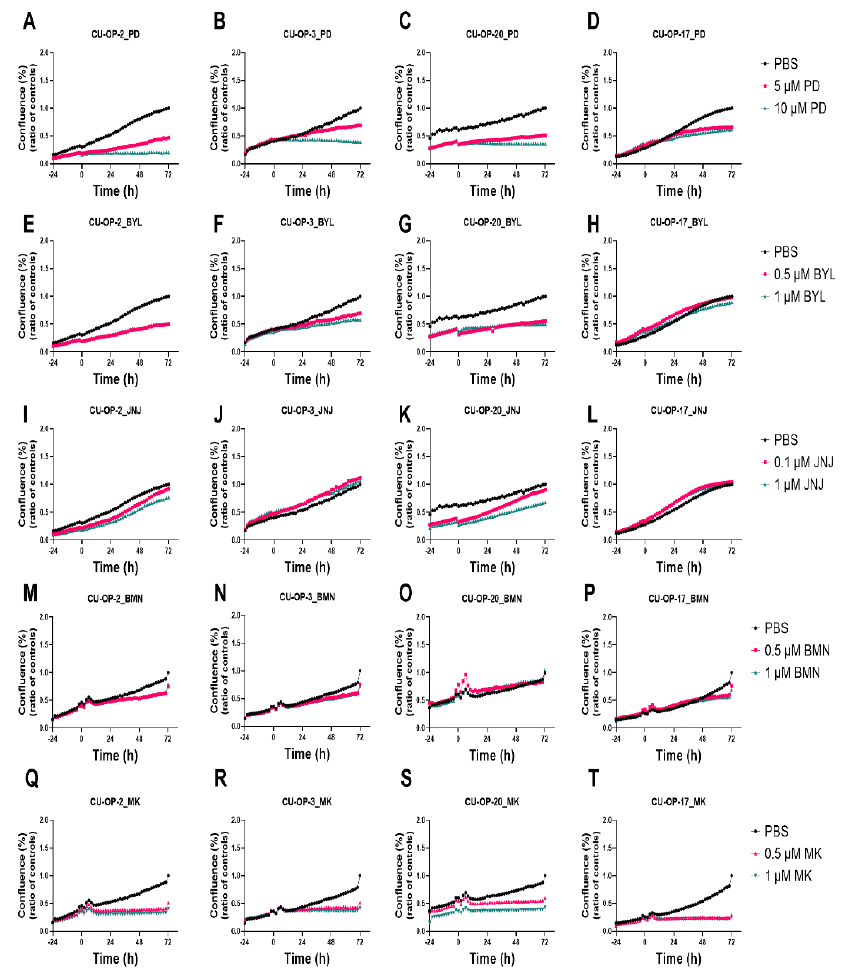
Figure 7. Proliferation response of HPV + CU-OP-2, CU-OP-3, CU-OP-20, and HPV − CU-OP-17 cell lines upon treatment with PD-0332991, BYL719 or JNJ-42756493, BMN-673, and MK-1775. Proliferation responses of HPV + CU-OP-2, CU-OP-3, CU-OP-20, and HPV − CU-OP-17 after treatment with CDK4/6 inhibitor PD-0332991 ( A – D ), PI3K inhibitor BYL719 ( E – H ), FGFR inhibitor JNJ-42756493 ( I – L ), PARP inhibitor BMN-673 ( M – P ) and WEE1 inhibitor MK-1775 ( Q – T ). The graphs represent one experimental run per cell line. Confluence (%) denotes proliferation response; BYL denotes BYL719; JNJ denotes JNJ-4275649 and PD denotes PD-0332991; BMN denotes BMN-673; MK denotes MK-1775.